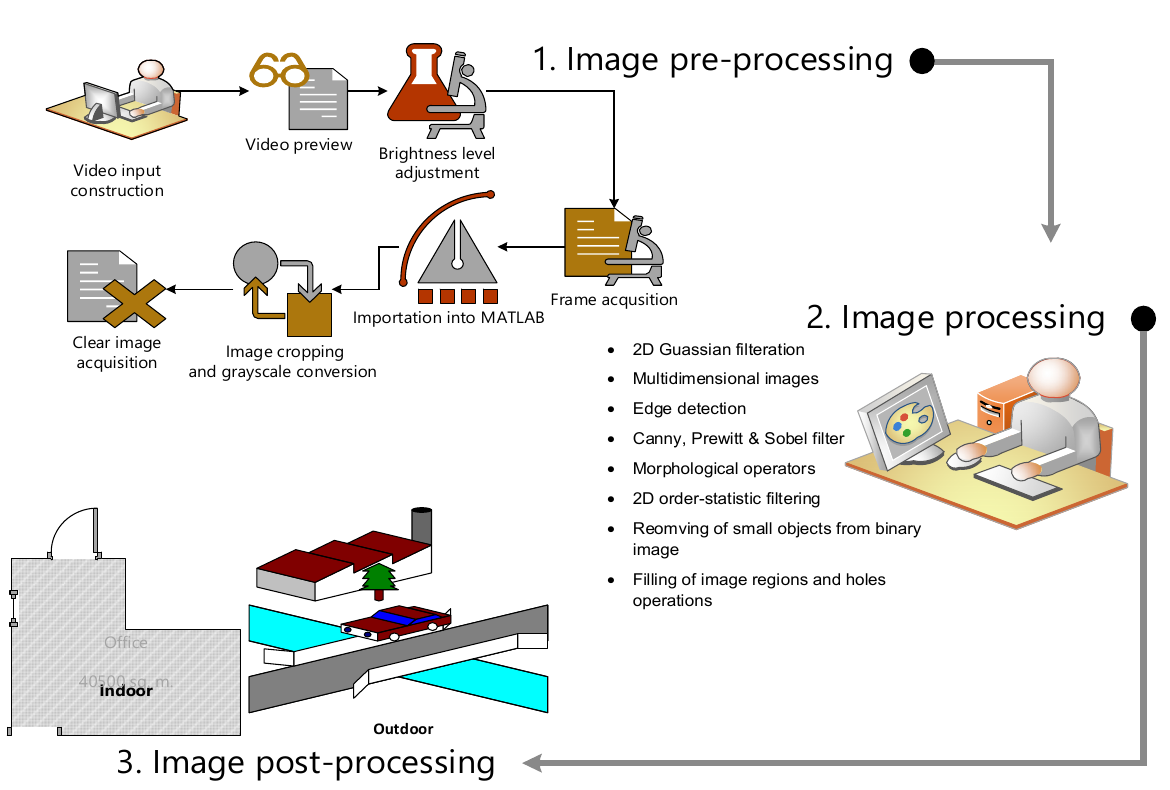
Figure 1. Image processing steps.